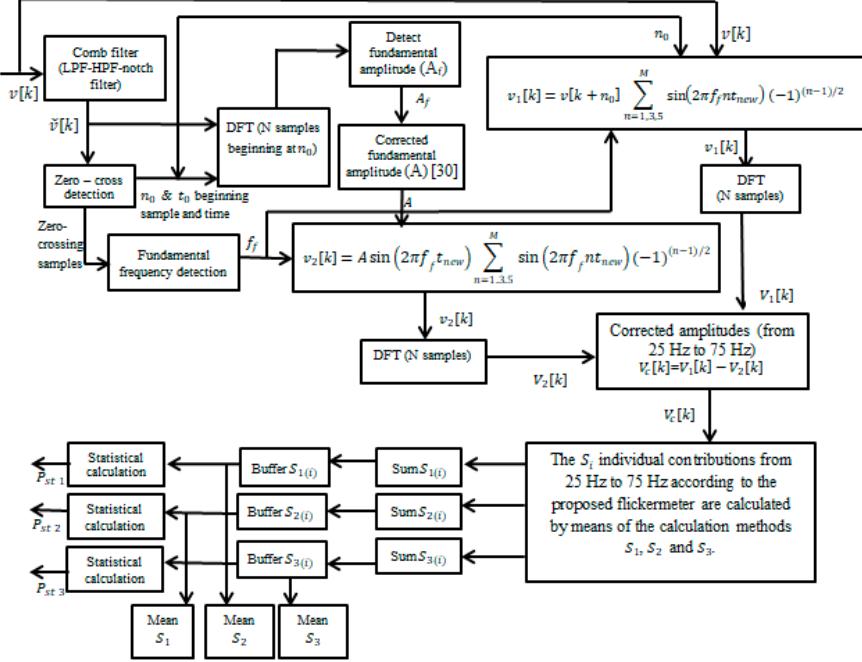
Figure 2. Block diagram of the proposed flickermeter for new generation lamps based on improved spectral decomposition approach.